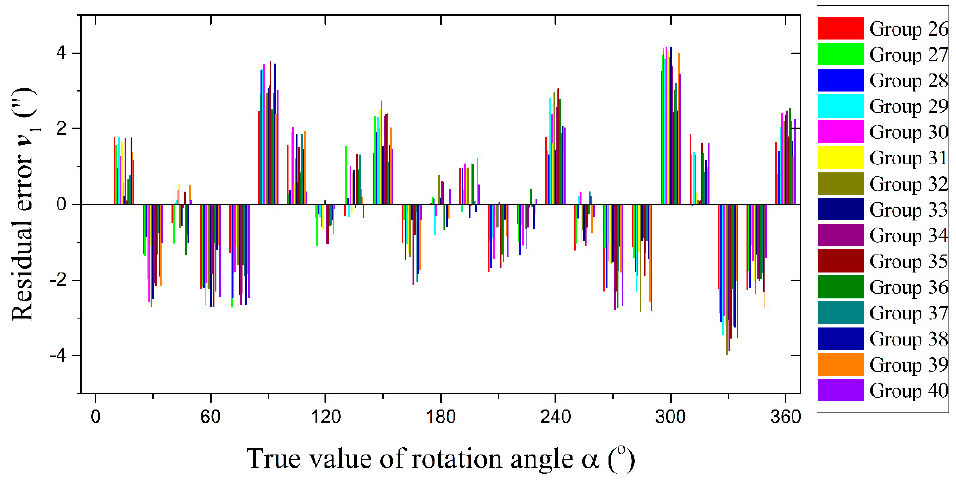
Figure 10. The residual error v 1 of reading head one after two progressive compensations (15 groups of measurement data).